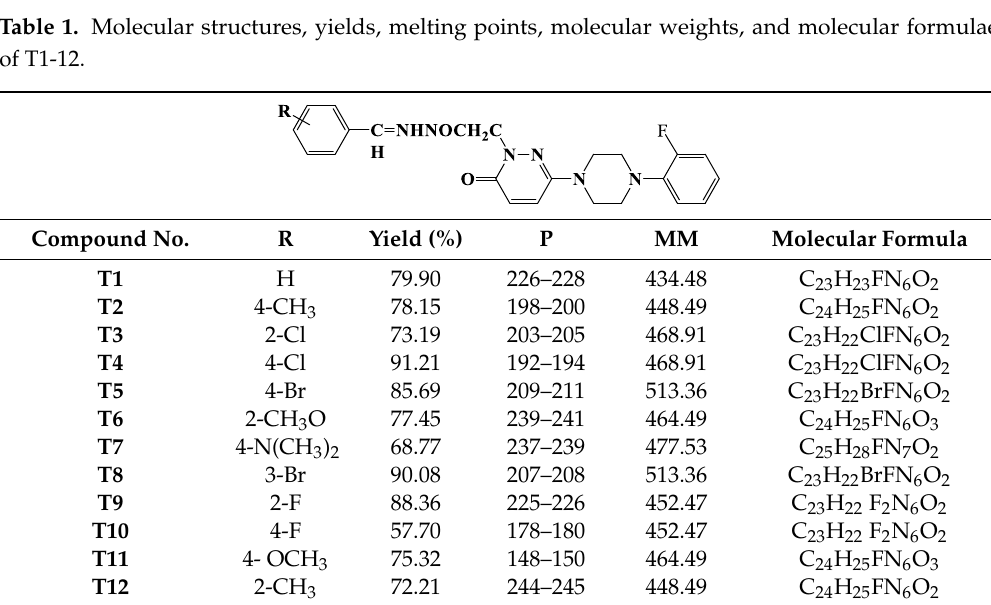
Table 1. Molecular structures, yields, melting points, molecular weights, and molecular formulae of T1-12.